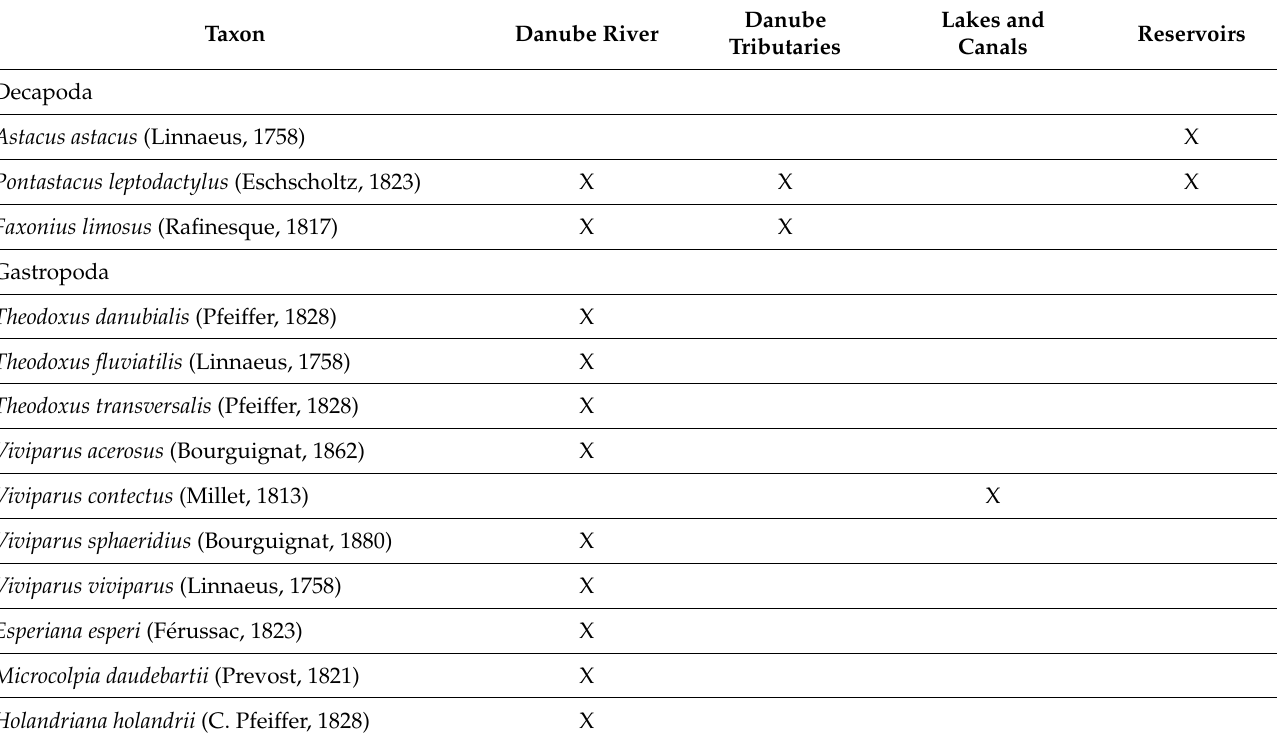
Table 2. List of all species of benthic macroinvertebrates (crayfish and molluscs) and fish recorded in the Bulgarian sector of the Danube River and adjacent water bodies during JDS4 (2019). X—indicates the presence of the species in the corresponding type of water body monitored (Danube River, Danube tributaries, lakes and canals, and reservoirs). For quantitative parameters, see Supplementary Materials Tables S2, S3, S5, S6, S8, S9 and